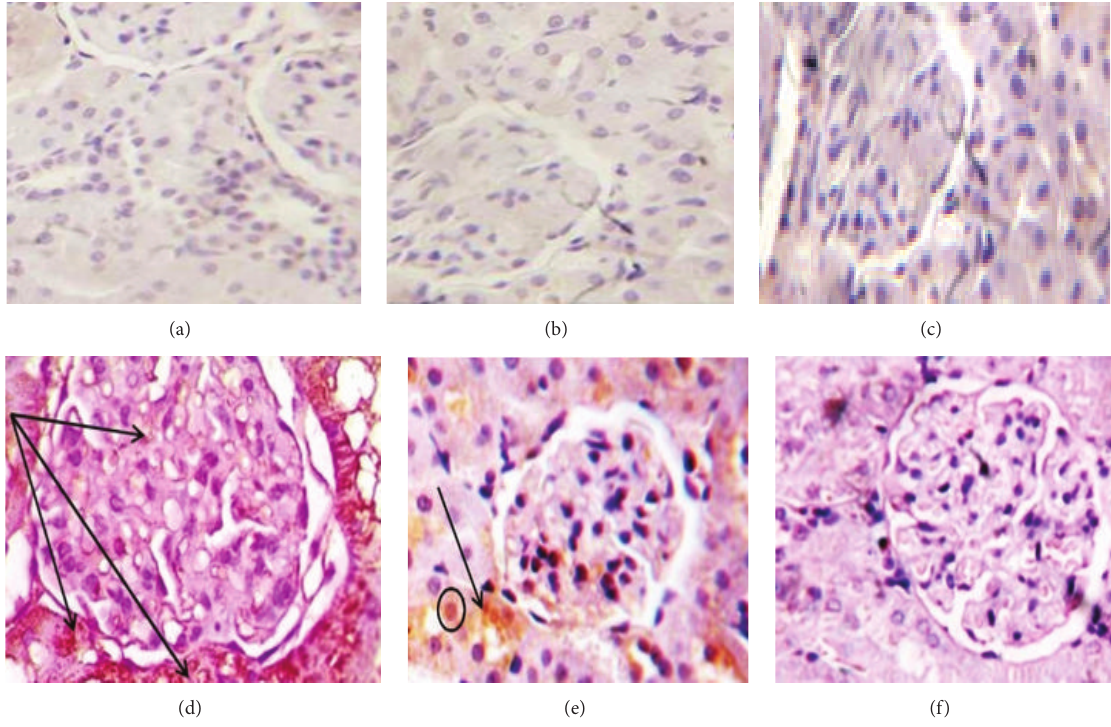
Figure 3: Photomicrographs of renal cortex immune stained for NF 𝜅 B of (a), (b), and (c), control, DLD, and DHD groups, respectively, showing negative immunoreactivity. (d) DOX treated group showing extensive expression in the renal glomeruli and renal tubules. (e) DOX/DLD group showing moderate expression within the glomeruli and the renal tubules. (f) DOX/DHD group showed marked improvement with no expression in glomeruli and renal tubules. The expression is mainly cytoplasmic but with some immunopositive nuclei. Immunohistochemistry counter stained with H&E × 400. Bar = 20 𝜇